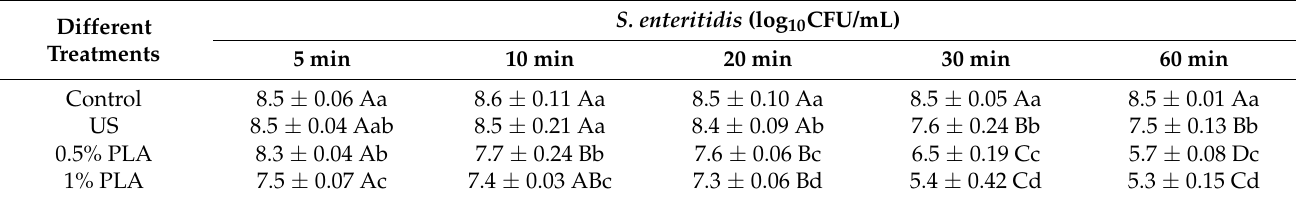
Table 2. Residual bacterial counts in S. enteritidis biofilms cells after the different treatments. Different